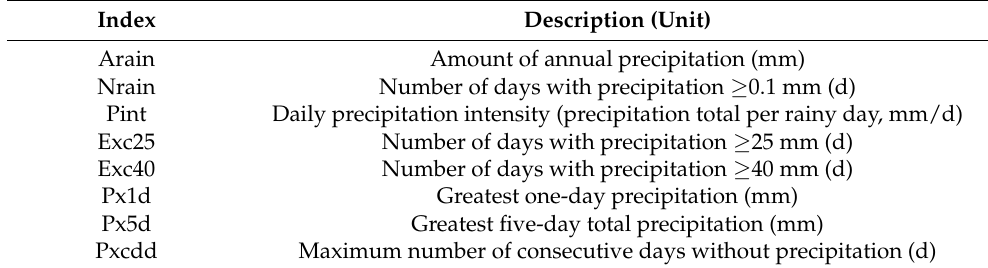
Table 1. Description of the eight precipitation indices used in the study.